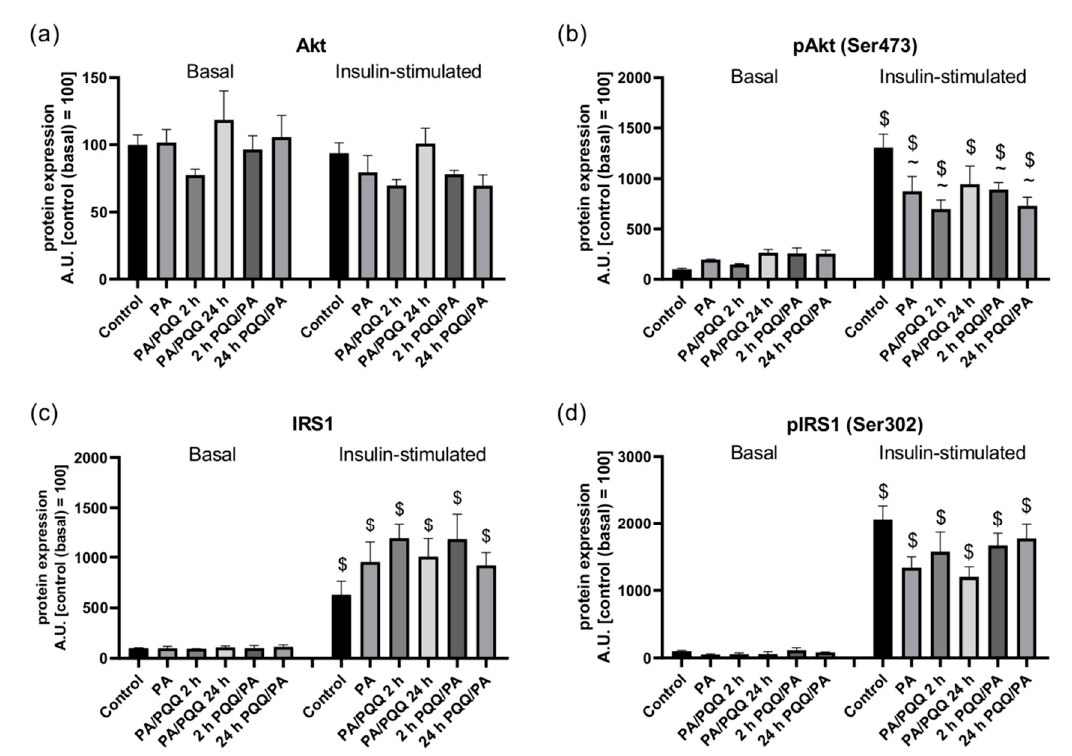
Figure A1. E ff ects of short- and long-time incubation with PQQ on the protein expression of ( a ) Akt, ( b ) pAkt (Ser 473), ( c ) IRS1, ( d ) pIRS1 (Ser302) in L6 myotubes. Control is set as 100 and the values are presented as mean ± SEM based on six independent determinations. ANOVA with a post hoc Tukey’s test was applied. ~ p < 0.05, study groups versus control; $ p < 0.05, insulin-stimulated versus basal conditions. ANOVA: analysis of variance; GAPDH: glyceraldehyde 3-phosphate dehydrogenase; PA: palmitic acid; PQQ: pyrroloquinoline quinone. Table A4. Annealing temperature and specific primer sequences for target genes in real-time PCR reaction.